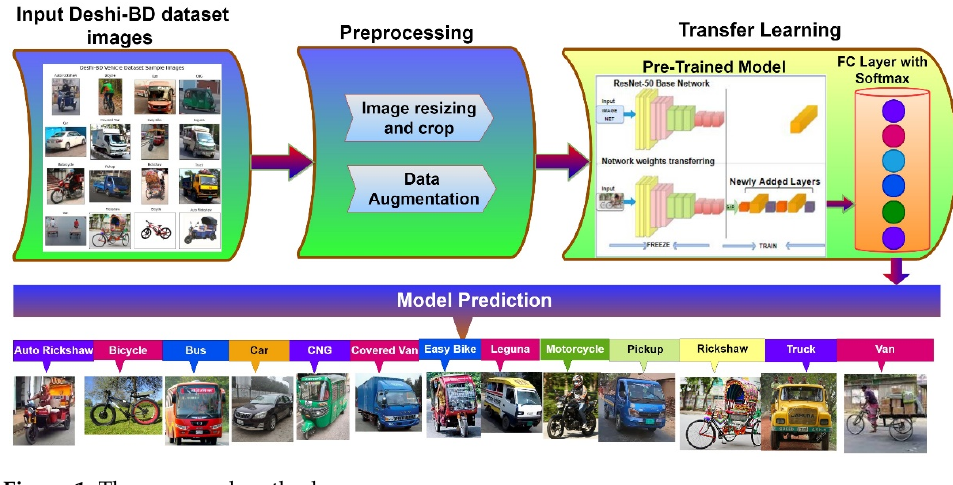
Figure 1. The proposed method.